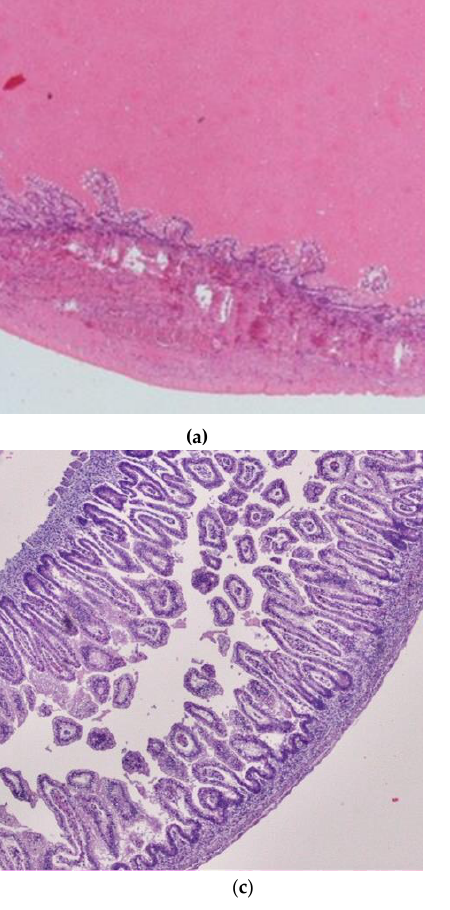
Figure 2. Intestinal wall comparison between CMV-infected fetuses with and without HB. CMV-infected fetuses with HB: ( a ) The intestinal villi were compressed and flattened by intraluminal meconium (HE staining; 2HPF); ( b ) The enterocytes showed brown pigments (arrow) in the cytoplasm due to meconium absorption (HE staining; 10HPF). CMV-infected fetuses without HB: ( c ) Intestinal wall without meconium in the lumen showing elongated and finger-like villi (HE staining; 2HPF); ( d ) The enterocytes displayed clear cytoplasm (HE staining; 10HPF).